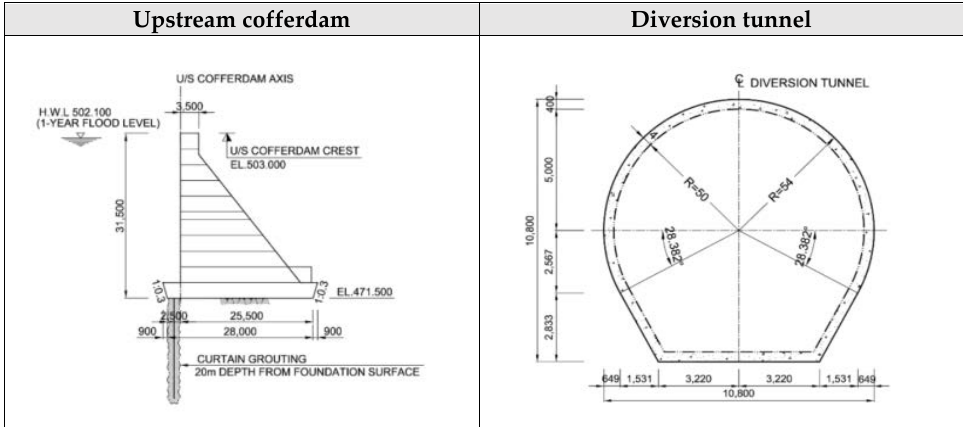
Figure 3. Diversion structure.